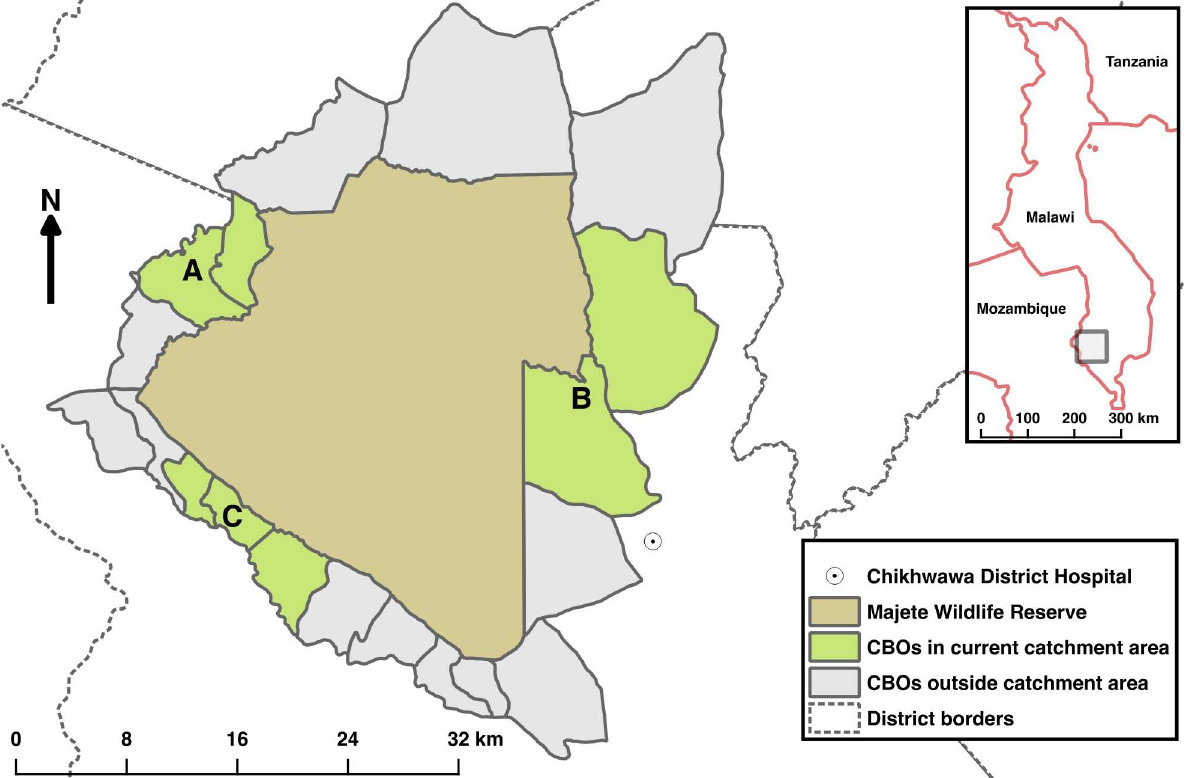
Fig 1. Map of Majete wildlife reserveand surrounding communities. Majete Wildlife Reserve (brown) is surroundedby 19 community basedorganisations—CBOs (grey and green) comprisingthe Majete perimeter. Three focal areas (green), labelledas A, B, and C mark the communities selectedfor malaria indicatorsurveys. The rest of the CBOs (grey) are outside the projects catchment